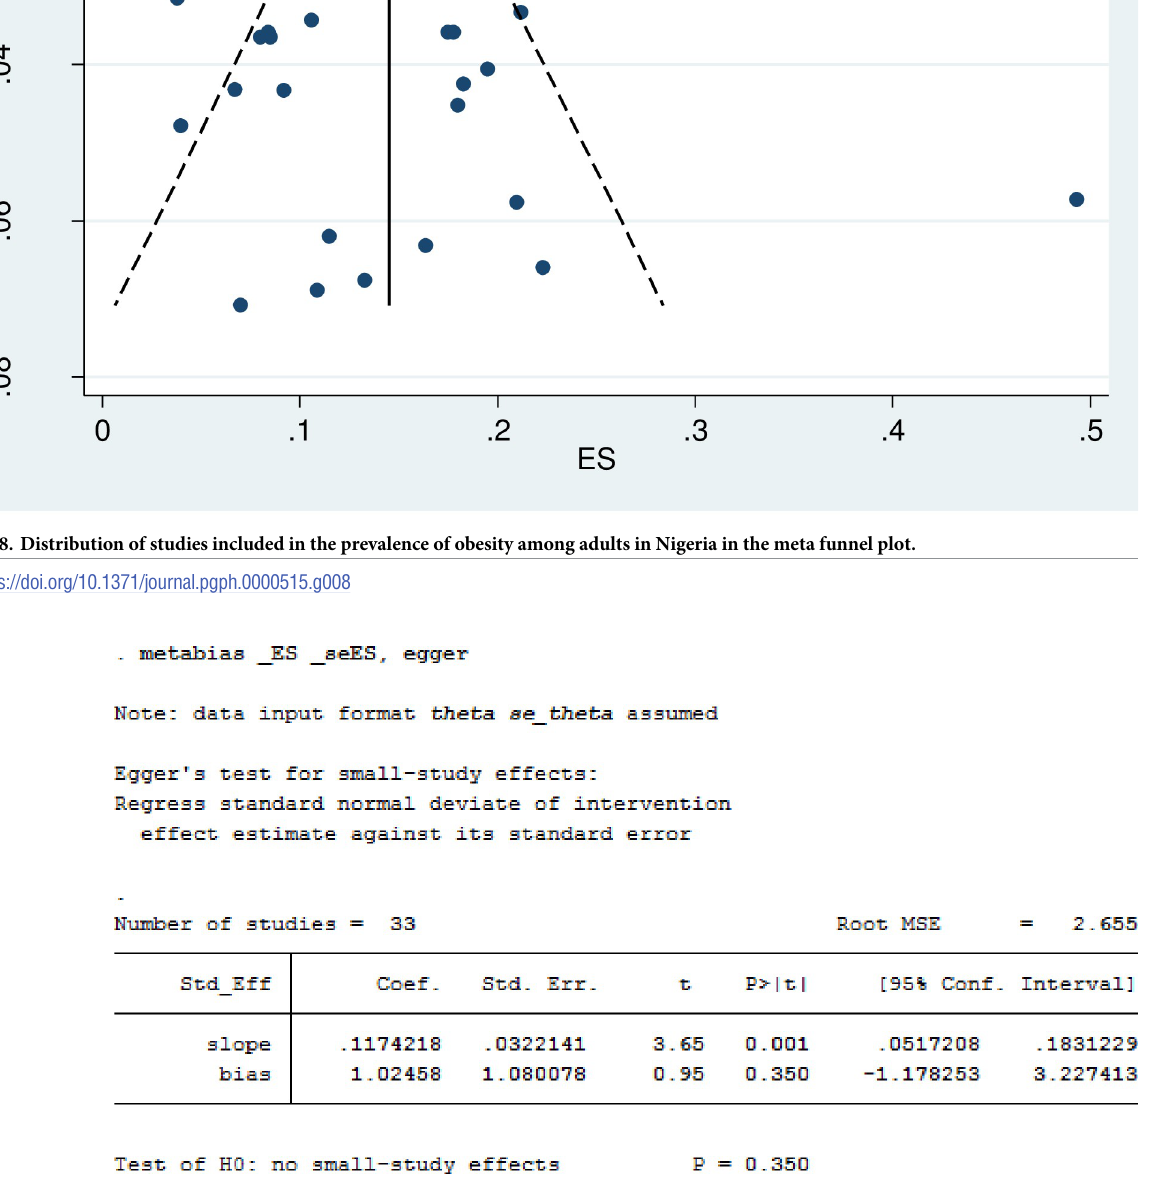
Fig 9. Egger’s test for detection of publication bias for studies included in the prevalence of obesity among adults in Nigeria.